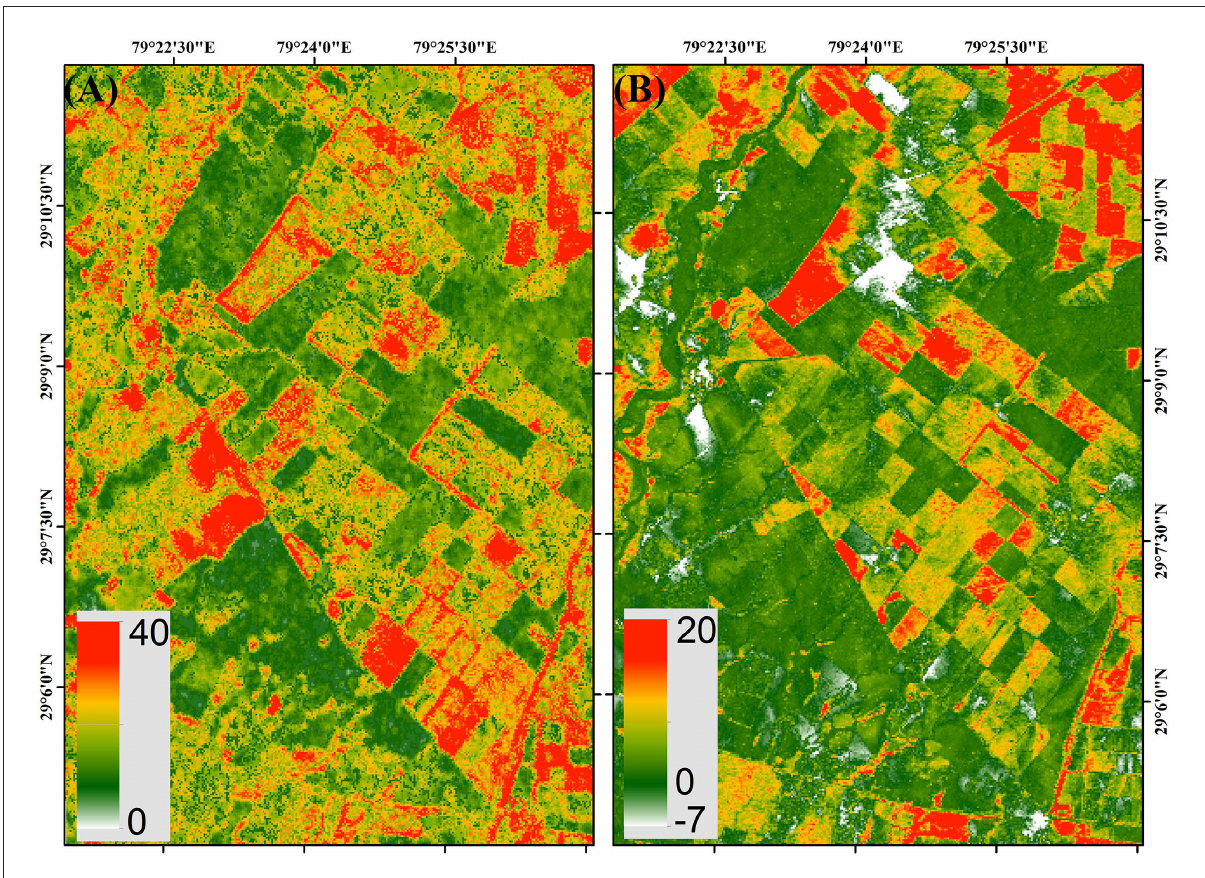
FIGURE4 (A) TanDEM-X PolInSAR estimated height (in meters) map using the data acquired on 09 Dec 2014. (B) Vegetation bias height estimated from the difference between 12 m TanDEM-X DEM and the interpolated